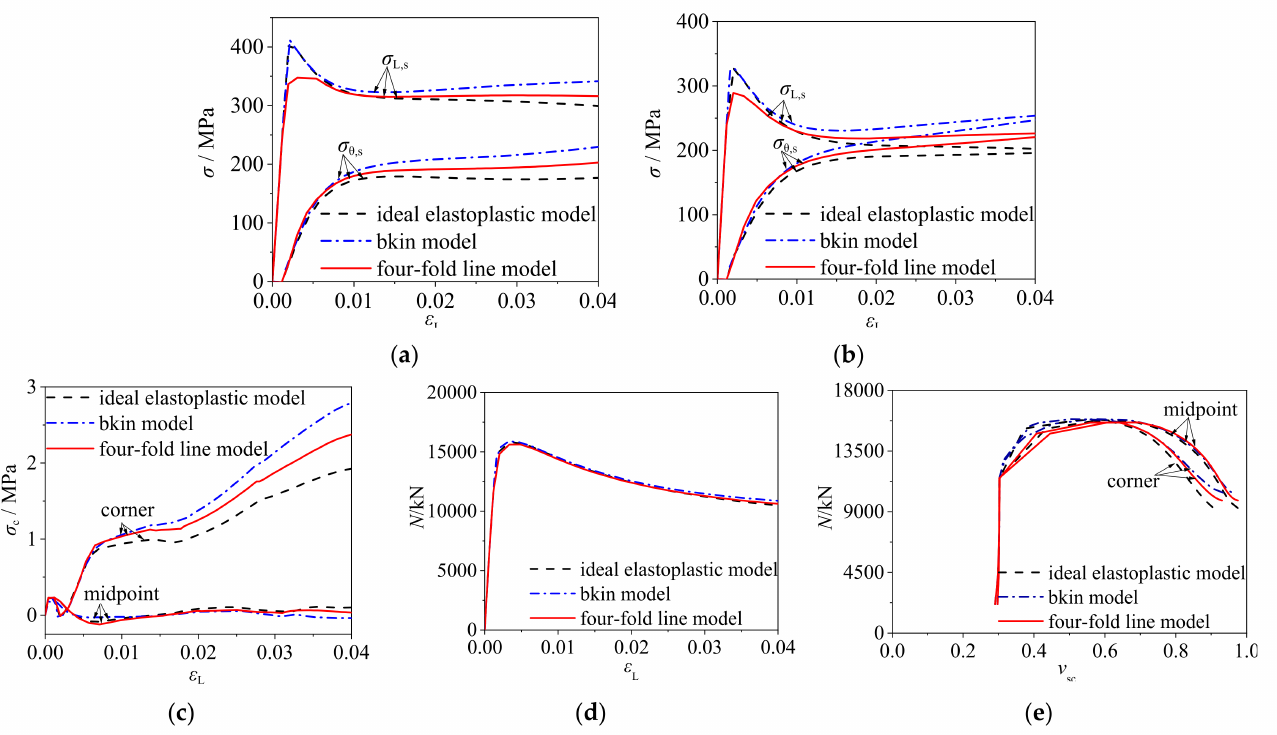
Figure 5. Comparison of typical curves for CFCFST adopting different constitutive models of cold-formed steel: ( a ) stress– strain curves of steel tubes at point A1, ( b )stress–strain curves of steel tubes at point A2, ( c ) radial stress–strain curves of core concrete, ( d ) load–strain curves, and ( e ) load–strain ratio ( N - ν sc ) curves of steel